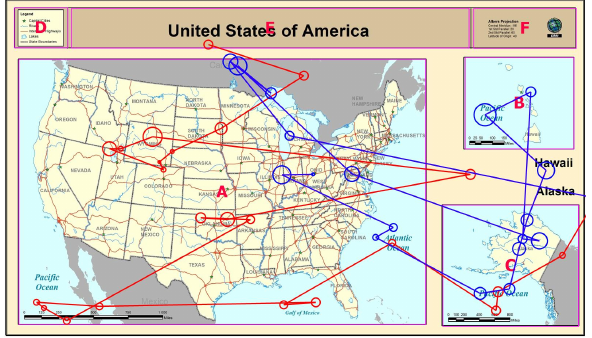
Figure 4. Comparison of trajectories S1 and S17, which were selected by eyePatterns as very